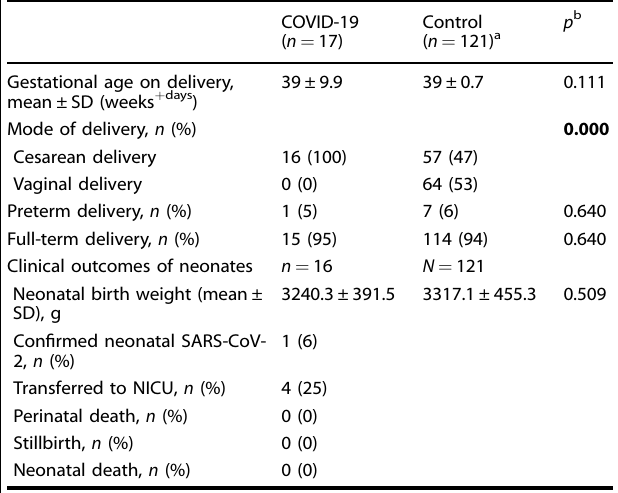
Table 2. Obstetric and perinatal